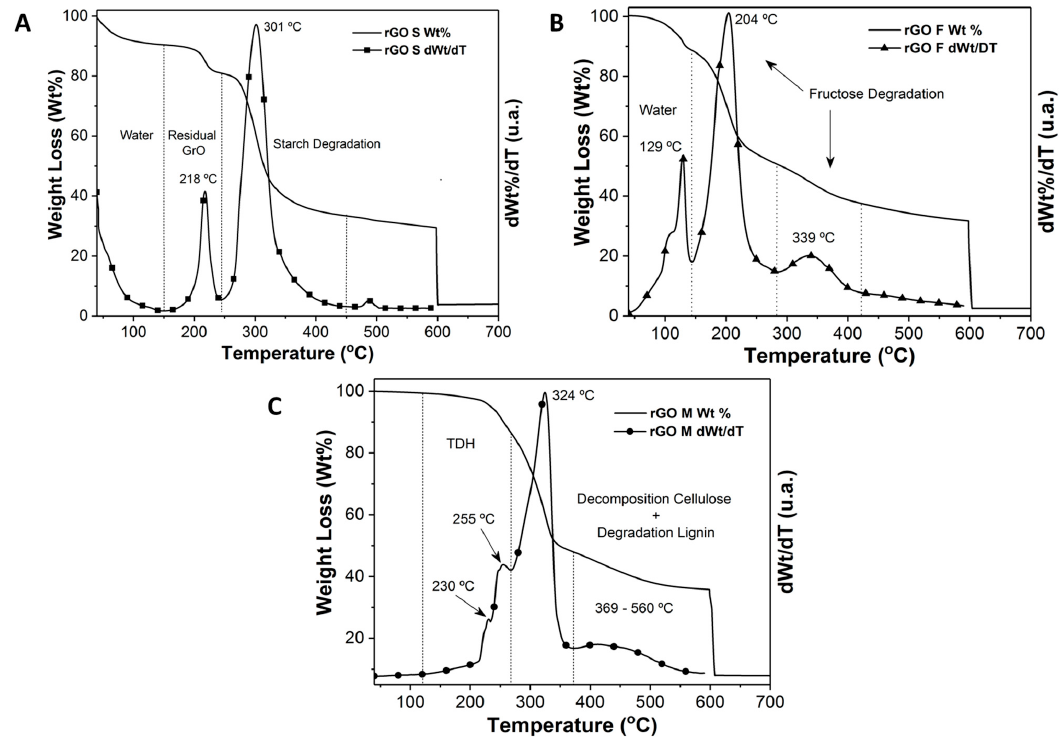
Figure 4. TGA of ( A ) rGO S, ( B ) rGO F, and ( C ) rGO M nanohybrids.